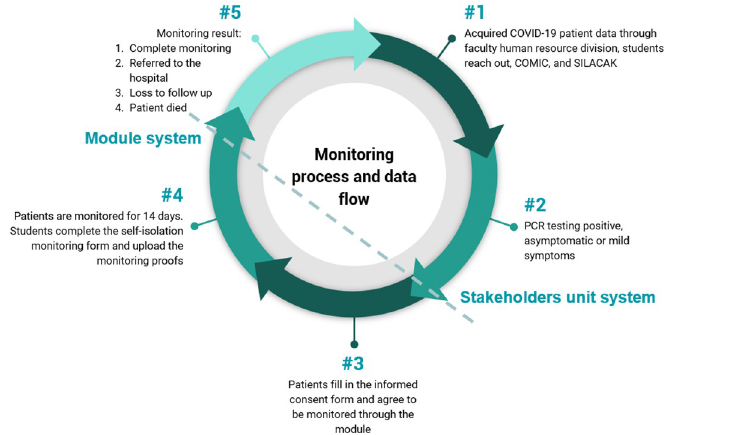
Fig 2. Monitoring process and data flow of the module.